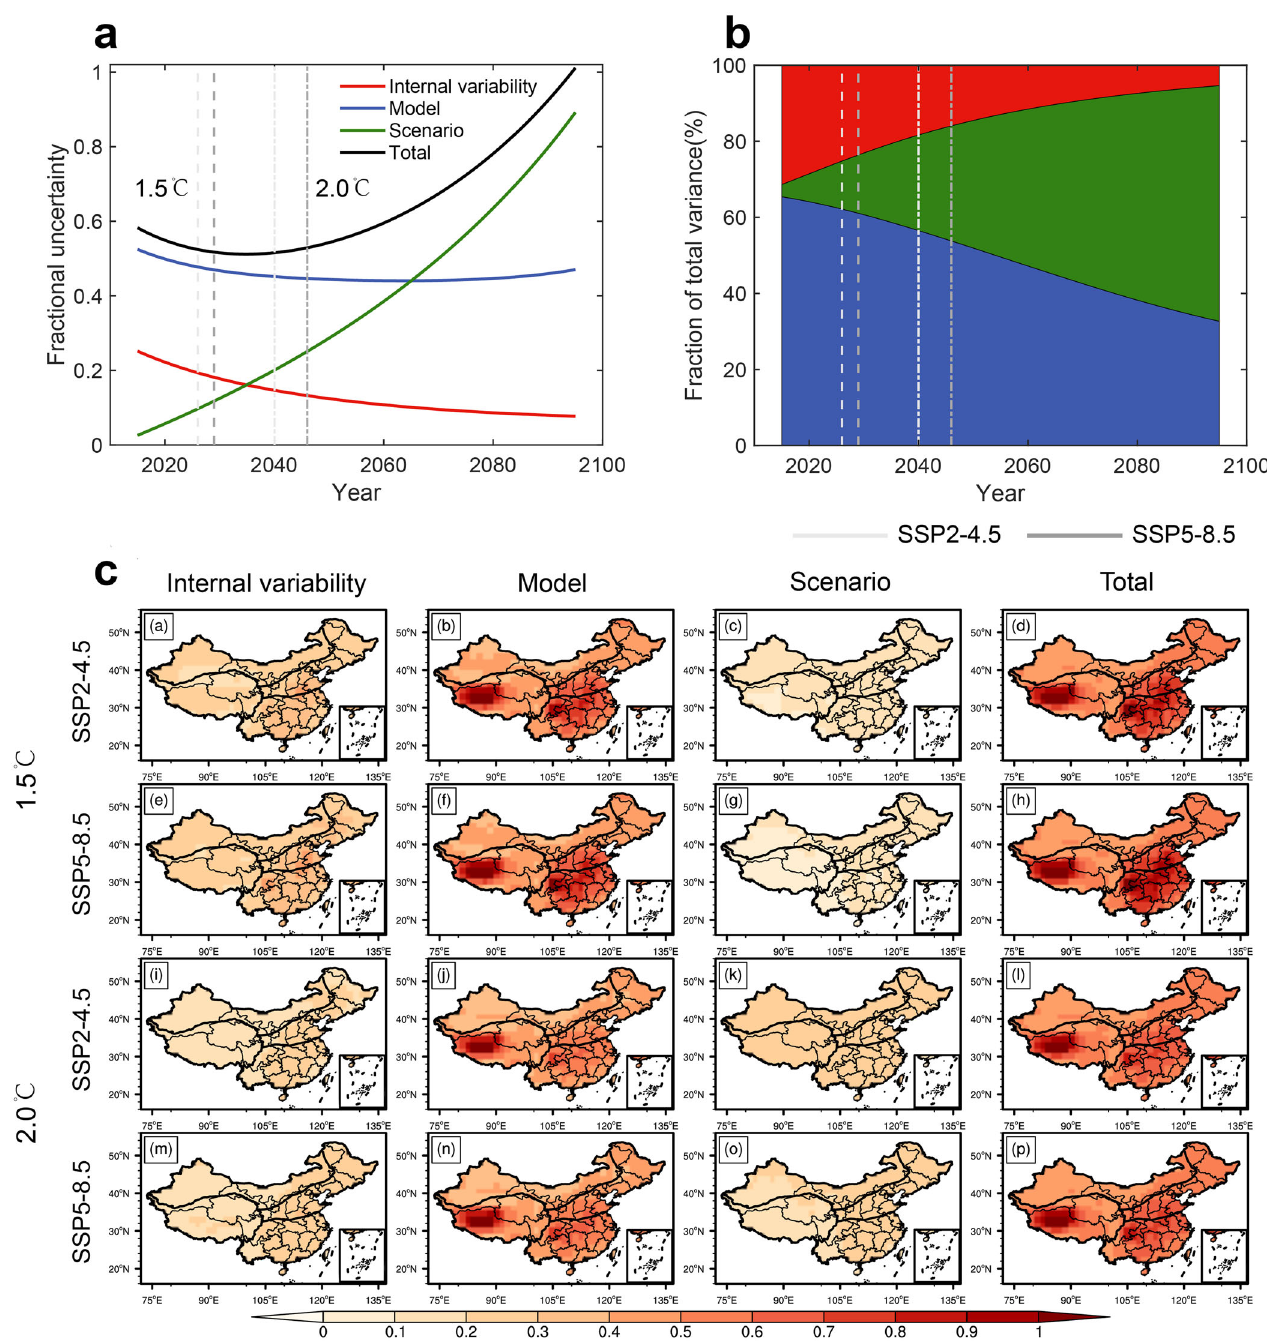
Fig. 8 The uncertainties for CMIP6 near-surface temperature projections in China. a Evolution of total uncertainty (black line) and the contribution of individual sources to the total uncertainty. The blue line corresponds to model uncertainty, green line to scenario uncertainty, and red line to internal variability. The long/short dashed vertical lines indicate when mean global warming reaches 1.5 °C/2 °C relative to pre- industrial (1850 – 1900) under the SSP2 – 4.5 (light gray) and SSP5 – 8.5 scenarios (dark gray). b Fraction of total variance accounted for by each type of uncertainty for near-surface mean predictions in China. c Spatial patterns of the uncertainty for internal variability ( fi rst column), model uncertainty (second column) and scenario uncertainty (third column), and the total uncertainty (fourth column) in China at GW1.5 and GW2 relative to pre-industrial (1850 – 1900) under the SSP2 – 4.5 and SSP5 – 8.5 scenarios. This is adapted from Figs. 9 and 10 of You et al. bias correction 155 , and MME-based GCM bias correction 156 . Together such studies suggest that GCM bias correction can signi fi cantly improve dynamical downscaling simulations compared with a traditional dynamical downscaling approach 150,152 . An emergent constraint method is a new approach to reducing future uncertainty and has received more recent attention 157 .